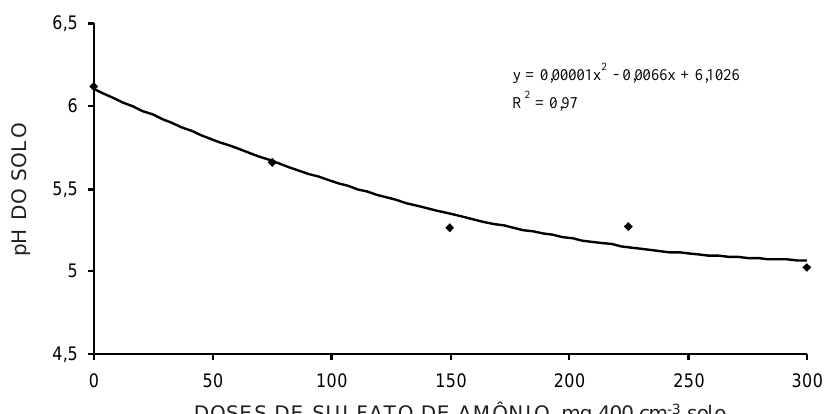
Figura 2. Valores de pH do solo, considerando as doses de sulfato de amônio presente nas misturas após 23 dias de